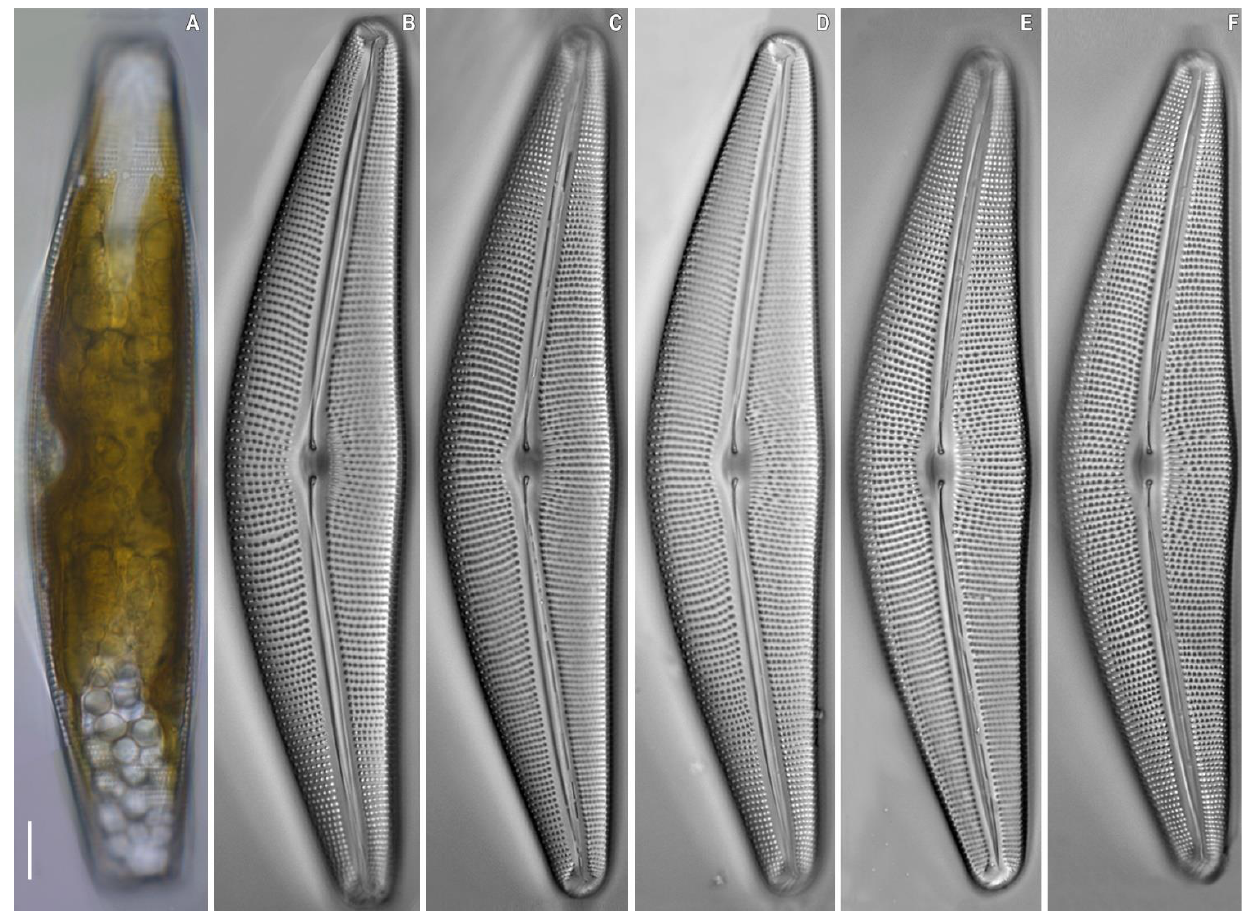
Figure 5. Cymbella baicalaspera Glushchenko, Kulikovskiy and Kociolek sp. nov. Strain B207. Light microscopy, differential interference contrast, size diminution series. ( A ) Live cells with chloroplast structure . ( B – F ) Oxidized material. Slide No. B207. ( B ) Holotype. Scale bar = 10 μm.